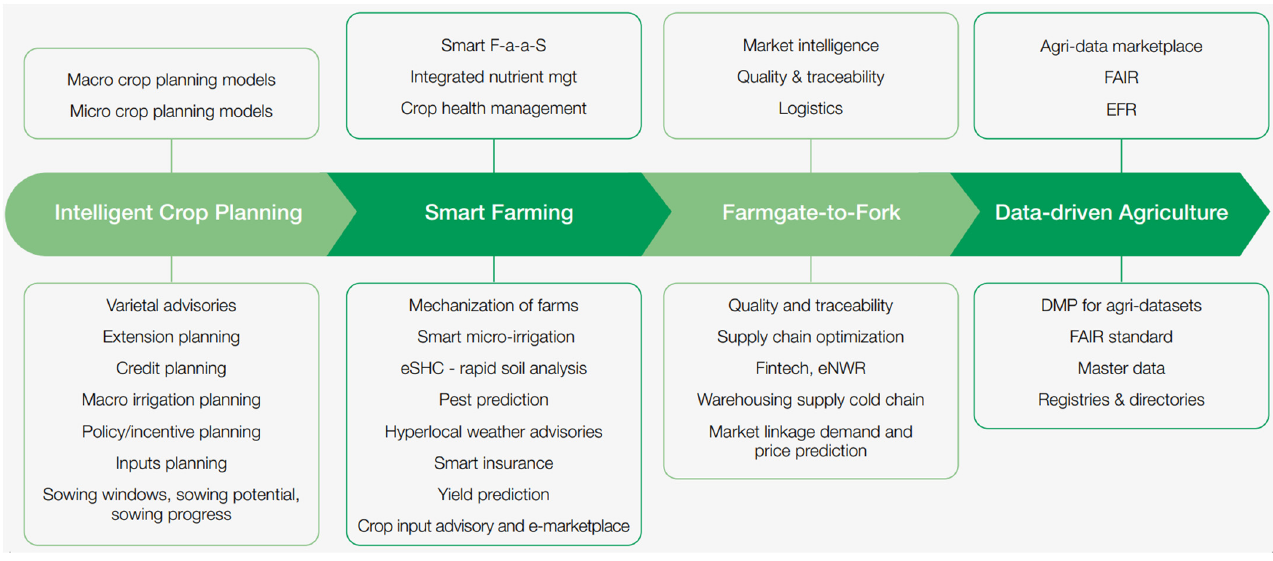
Figure 1. Smart farming and other emerging innovations in the agricultural sector